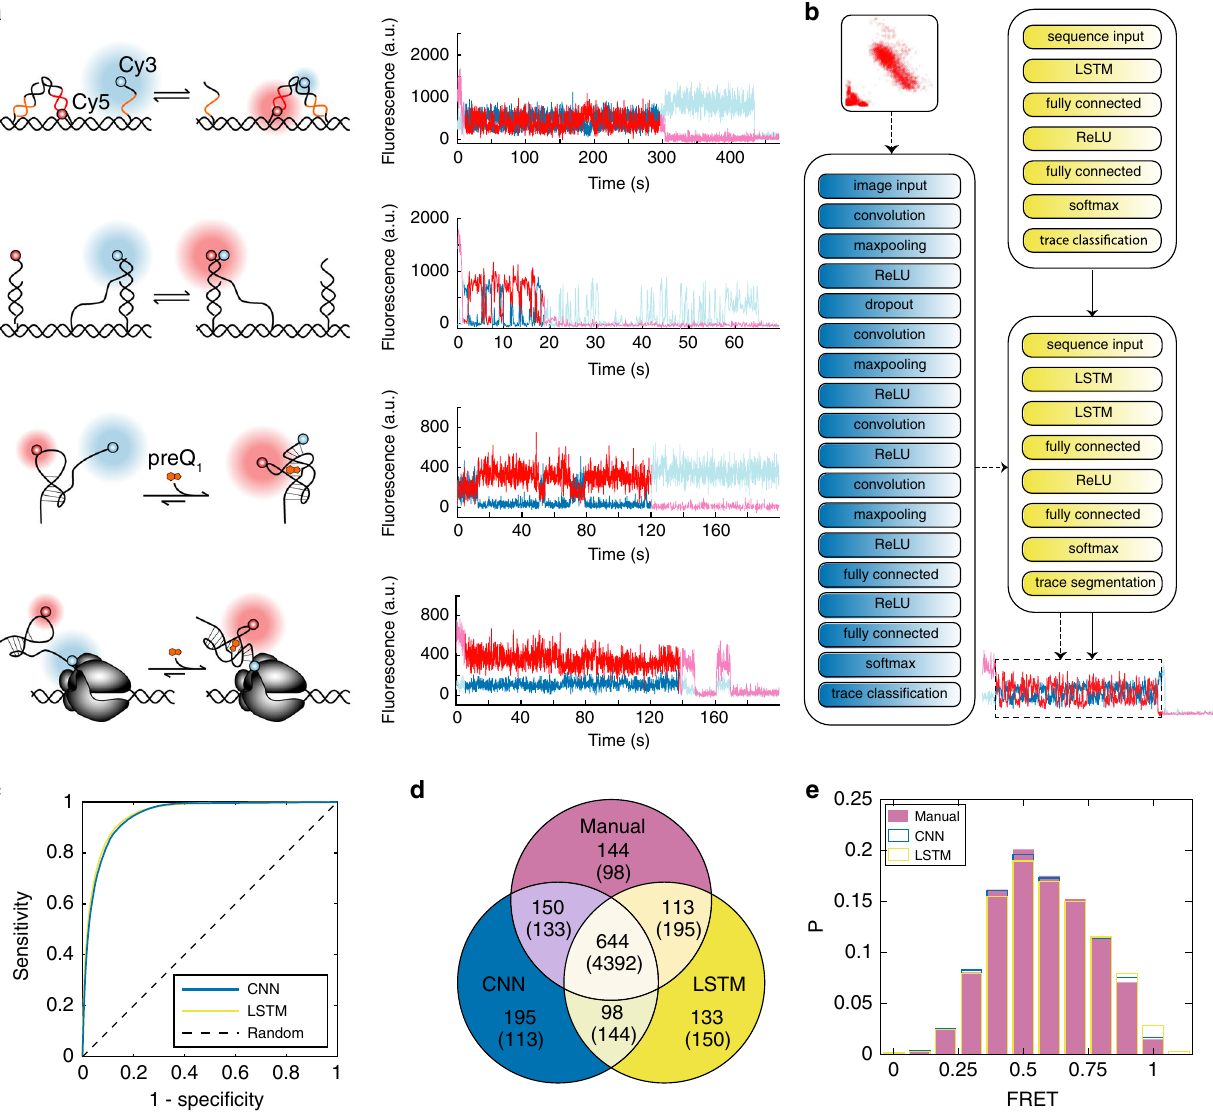
Fig. 3 Classi fi cation and segmentation of two-color single-molecule FRET traces with the LSTM and CNN deep learning algorithms of AutoSiM. a Schematics and typical smFRET traces from the four experimental systems used in training and testing, from top to bottom in the panel: a toehold- exchange-based DNA walker 37 ; a DNA swinging arm 36 ; a preQ 1 riboswitch 39 ; and a paused transcriptional elongation complex 38 . Traces show variable numbers of anticorrelated changes in donor (blue) and acceptor (red) fl uorescence intensity typical of smFRET data. The elevated acceptor fl uorescence from 0 to 5 s in some of the traces is due to direct excitation of the acceptor to con fi rm its presence prior to the FRET measurement. b LSTM network structures for classi fi cation and segmentation (blue) and CNN network structure (yellow). The LSTM network accepts raw SMFM traces for training and testing, while the CNN network requires that each trace be converted into a 2-D scatterplot of donor and acceptor intensity, then into a 32-by-32-pixel image for processing by the CNN. c ROC curves for classi fi cation by the CNN and LSTM networks as compared to classi fi cations by human experimenters. Here, speci fi city and sensitivity are calculated in relation to manual selection outcomes rather than a known ground truth. AUC > 0.95 for both networks, indicating strong agreement with manual classi fi cation. d Venn diagram showing the concordance among manual selection, LSTM and CNN for a representative test set of single-molecule trace data. Numbers in the Venn diagram represent the number of traces accepted (rejected) by each method or combination of methods. e FRET histograms generated by CNN-classi fi ed, LSTM-classi fi ed, and manually selected traces from the same two original datasets. Data used is from a paused transcriptional elongation complex experimental both human and the classi fi er algorithm divided by the total traces processed per minute by human users (Supplementary number of input traces — as the performance metric for these Fig. 1), the trained LSTM networks classify ~1000 traces per smFRET data. For the classi fi cation LSTM network, an average minute and perform segmentation of approximately 1,000 traces concordance of 90.2 ± 0.9% was achieved for 10 training and test per minute on a desktop with Intel i5 3.4 GHz CPU, accelerating sets sampled at random from the same experimental dataset analysis 100- to 500-fold while maintaining high concordance comprising 122 raw movies (Supplementary Tables 1 and 2). For with human experimenters. the segmentation LSTM network, an average frame-to-frame A hallmark of FRET measurements is to evaluate the degree of concordance of ~95% was achieved. In contrast to the pace of 1 – 5 anticorrelation between donor and acceptor fl uorophore emission